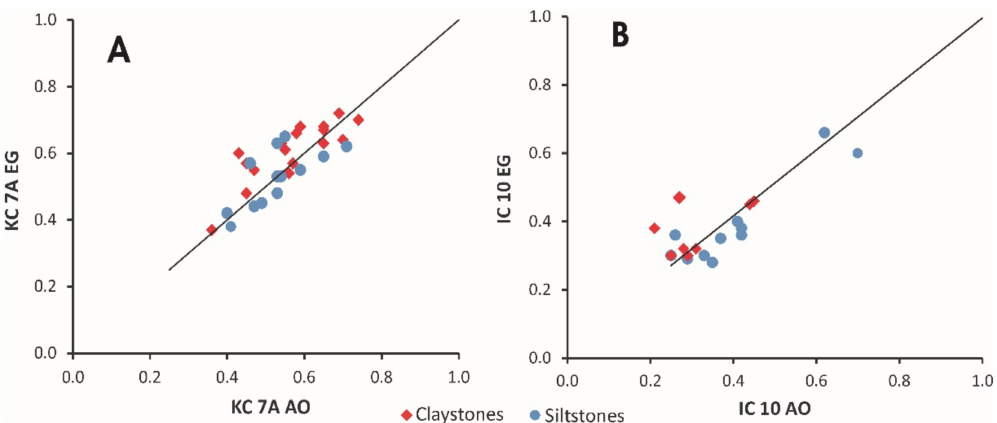
Figure 3. ( A ) Kln crystallinity measured in AO samples vs Kln crystallinity measured in EG samples. ( B ) Illite crystallinity measured in AO samples vs. illite crystallinity measured in EG samples, both in clays and silts.